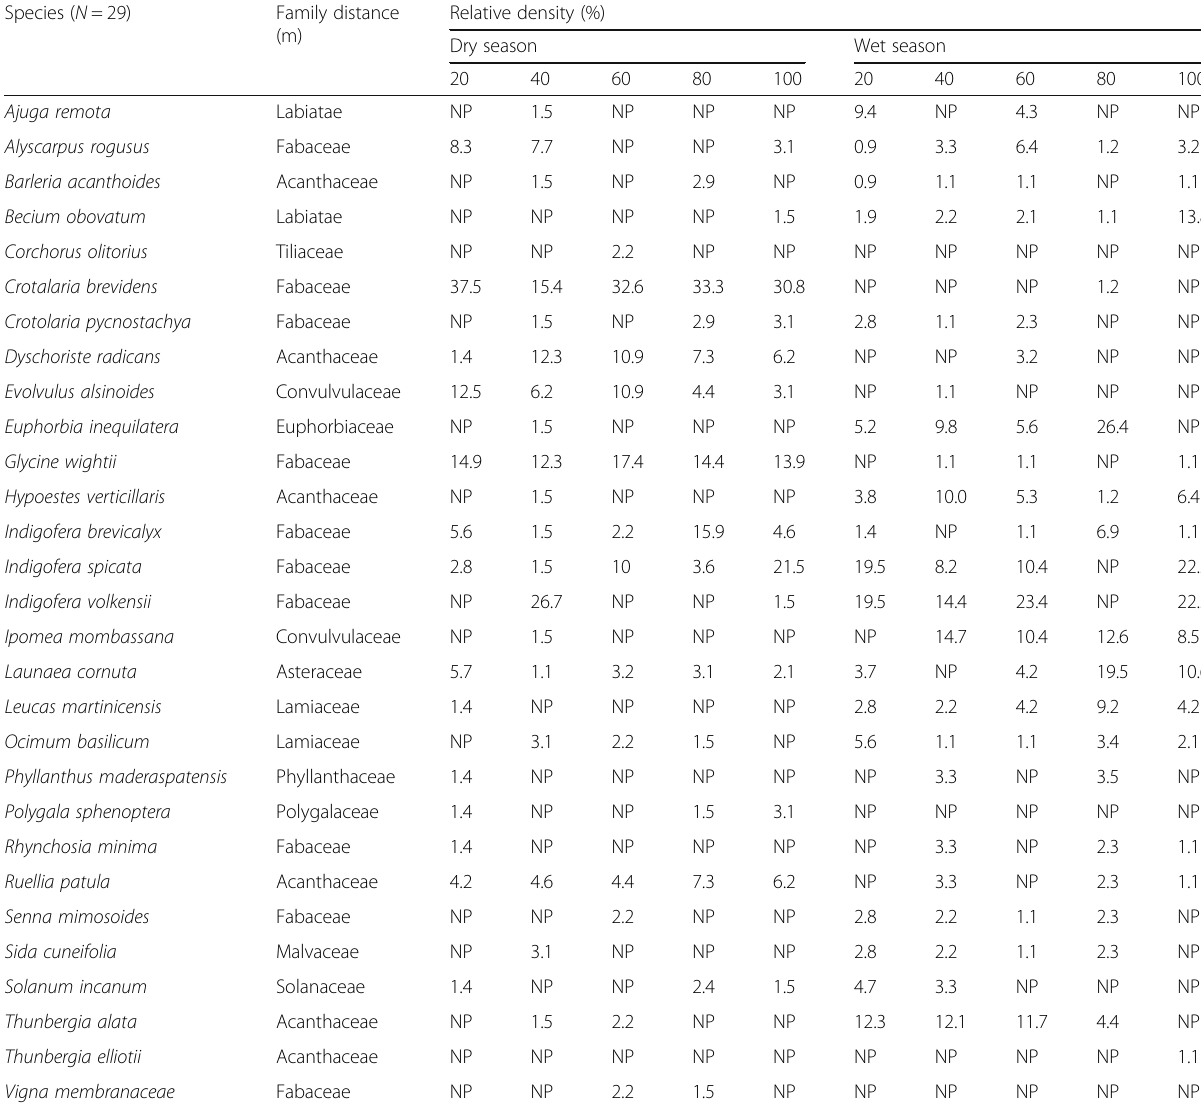
Table 2 Relative densities (%) of forbs at various piospheric distances Species ( N = 29) Family distance